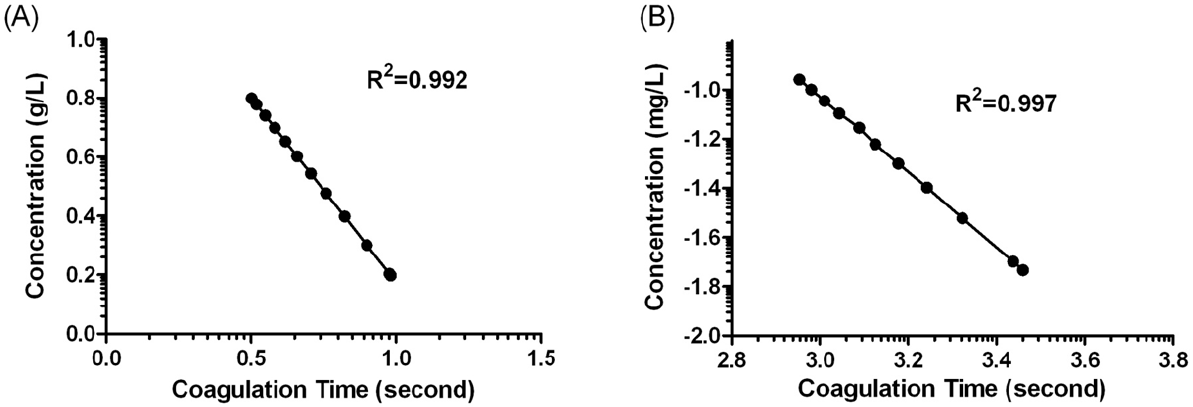
Figure 4. ( A ) The relationship between the log concentration of fibrinogen and log